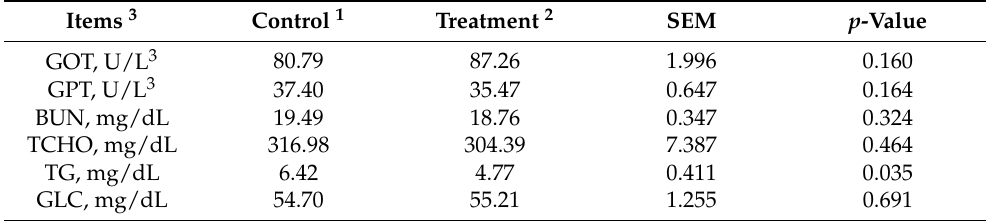
Table 9. Effects of noni meal on serum metabolites in Holstein dairy cows.